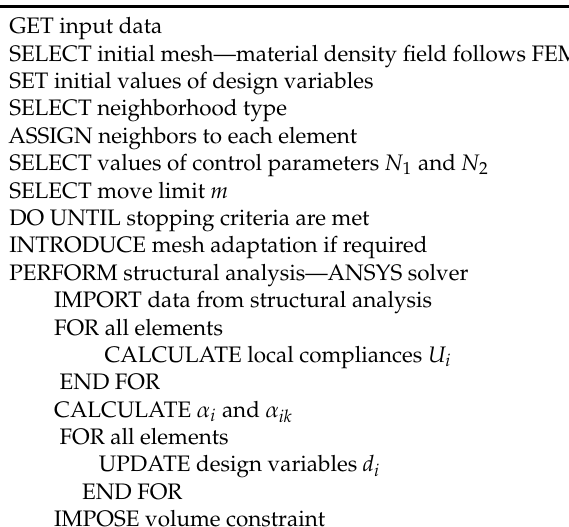
Table 1. The pseudo-code of the proposed